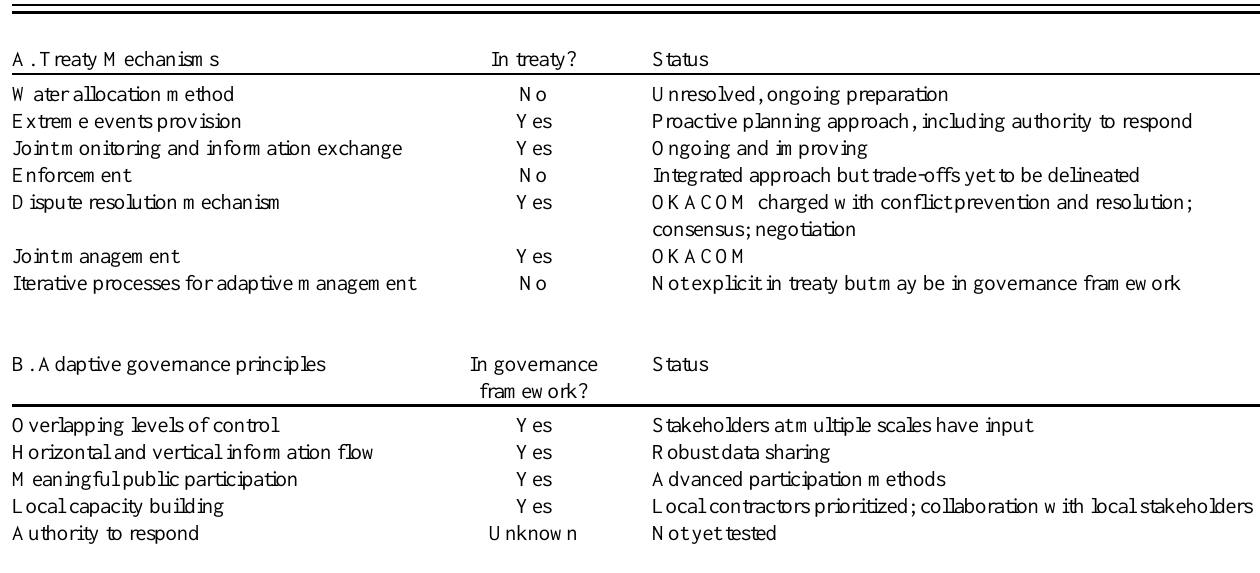
Table 1 . Summary of